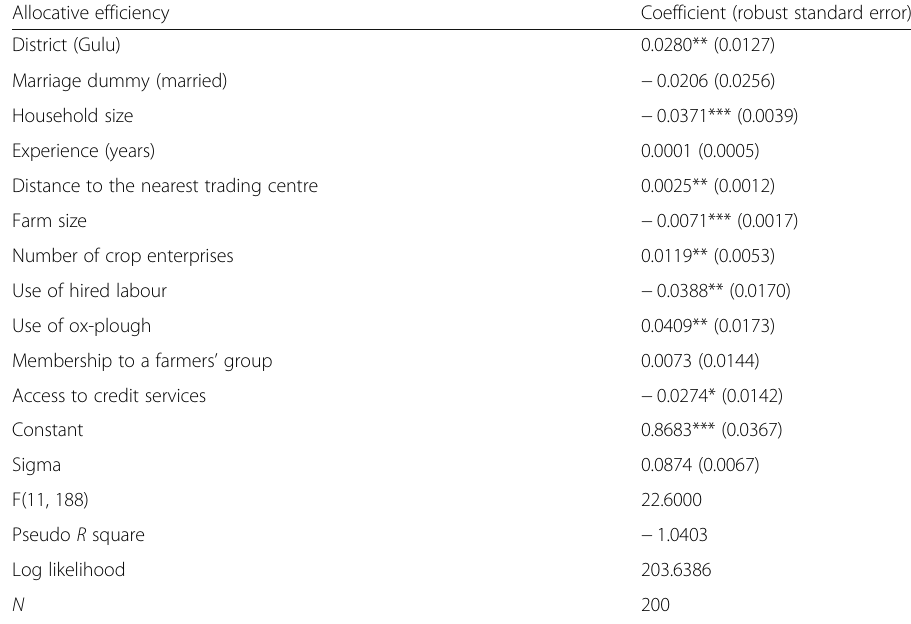
Table 5 Factors affecting allocative efficiency of rice production in Northern Uganda Allocative efficiency Coefficient (robust standard